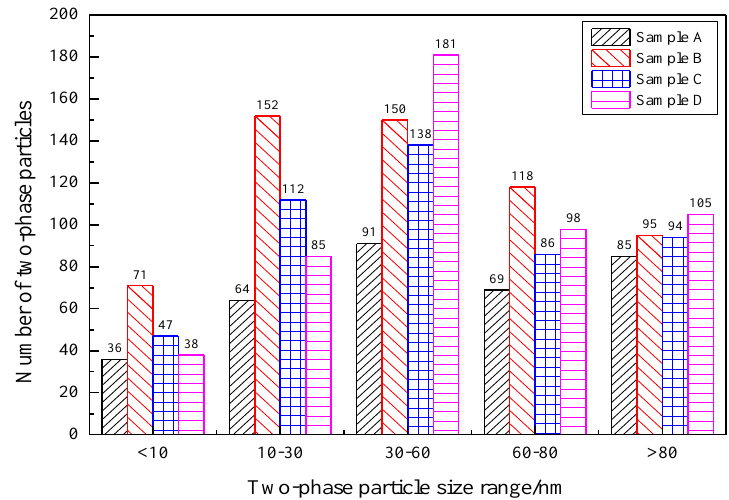
Figure 15. The size distribution of the precipitated phases in the sample. Table 4. Statistics of large-size precipitates in the sample.